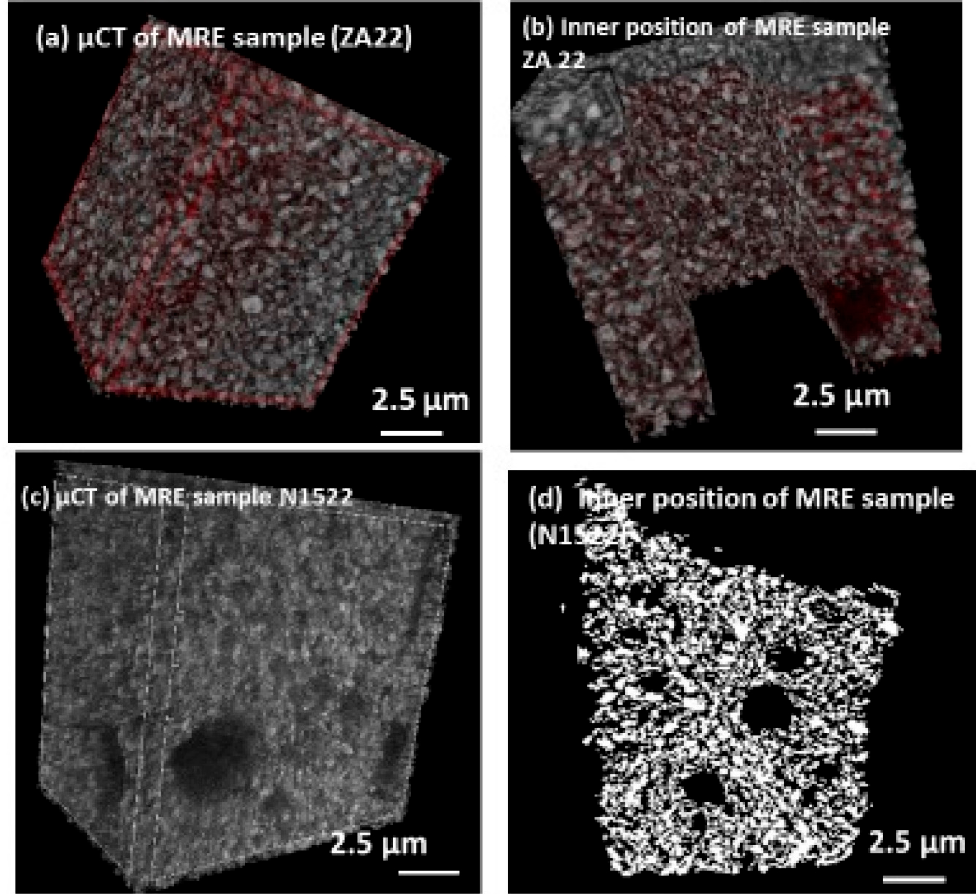
Figure 14. µCT surface features of MREs composite in 3D planes: ( a ) µCT of ZA22 MRE sample, ( b ) inner position of ZA22 MRE sample, ( c ) µCT of N1522 MRE sample, and ( d ) inner position of N1522 ( b ) inner position of ZA22 MRE sample, ( c ) µ CT of N1522 MRE sample, and ( d ) inner position of N1522 MRE sample. Reprinted from [18], © 2018 with permission from MPDI. MRE sample. Reprinted from [18], © 2018 with permission from